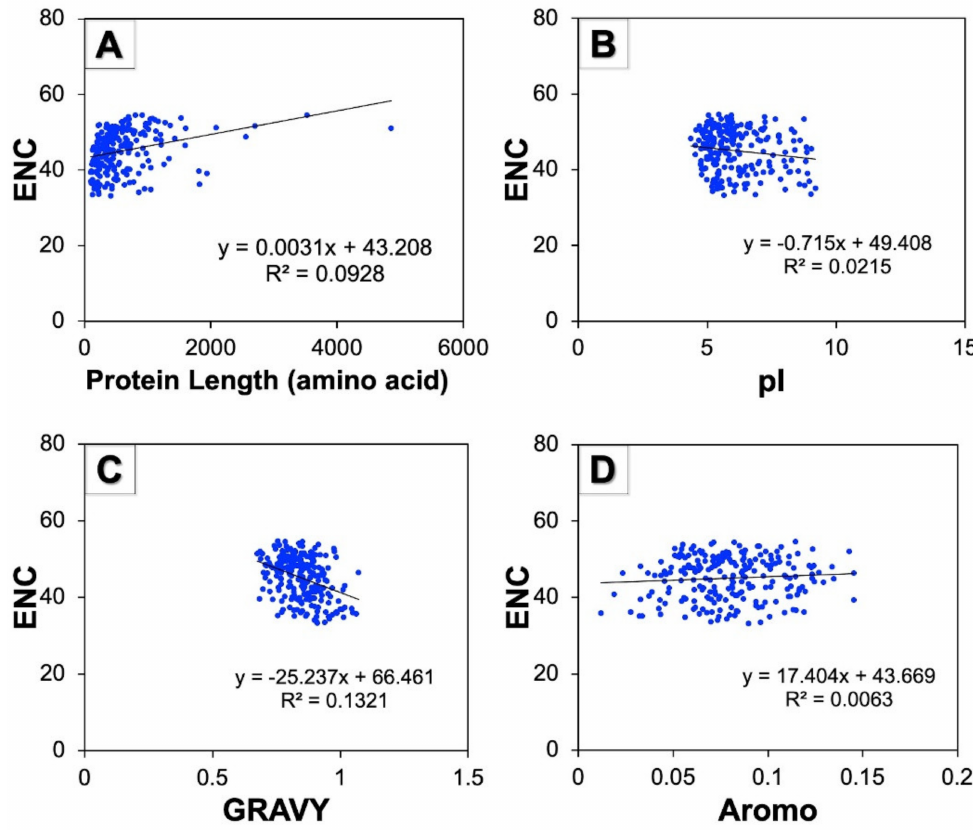
Figure 7. Regression analysis among ENC and various protein properties of human autophagy genes. ( A – D ) represent the scattered regression plots between ENC and protein length, pI, GRAVY, and Aromo,